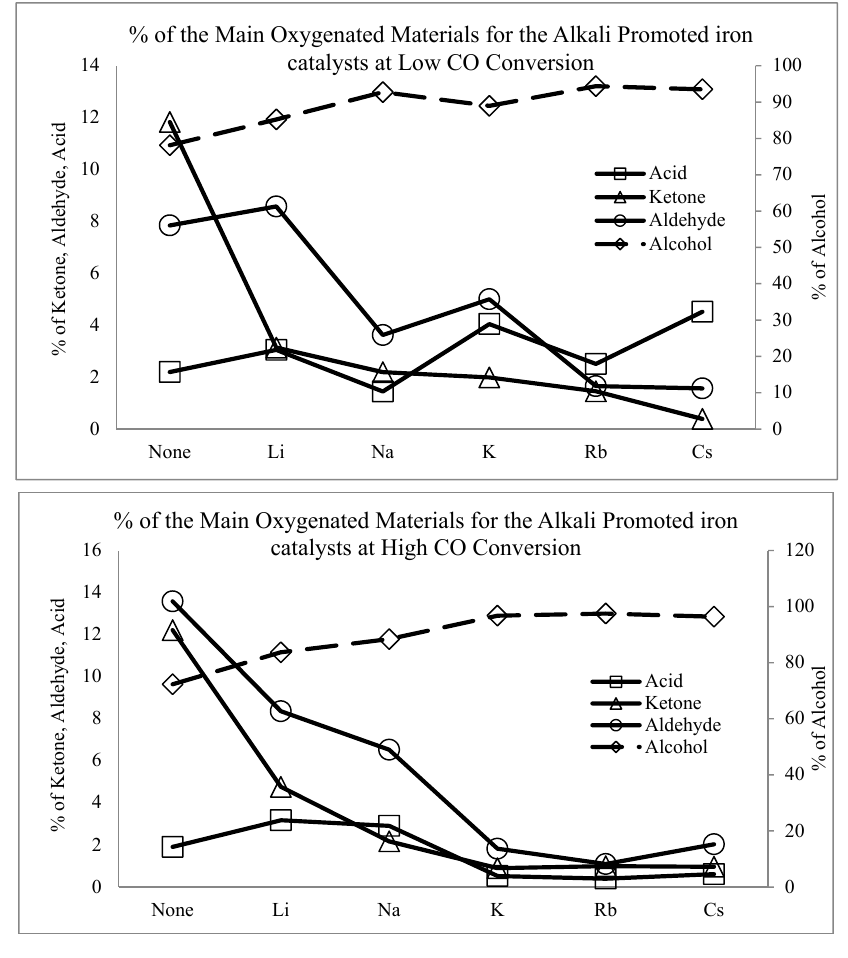
Figure 49. The % distribution of different oxygenated materials for each of the iron catalysts at low and high CO conversion. The percentage basis is taken as a % mole of carbon per functional group/%mole of C total oxygenates. Esters were observed, but they accounted for much less than one percent, with respect to the total oxygenates, and thus not added to this figure. Reactor conditions: 270 °C, 12.1 bar, WHSV = 2, and H 2 /CO = 0.7.